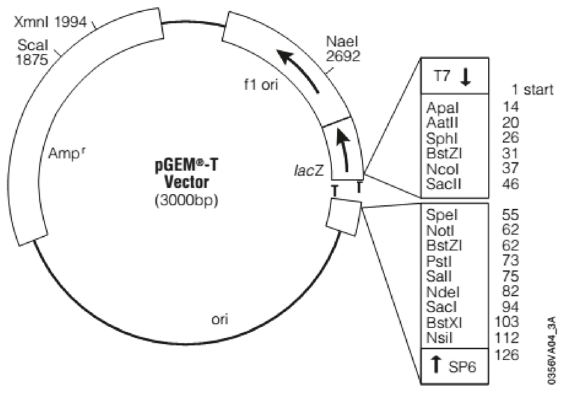
Figure 1: pGEM-T or pGEM-T easy vector (Genewiz, 2018). Table 1: Characteristics of the colonial morphology of the isolated LAB and